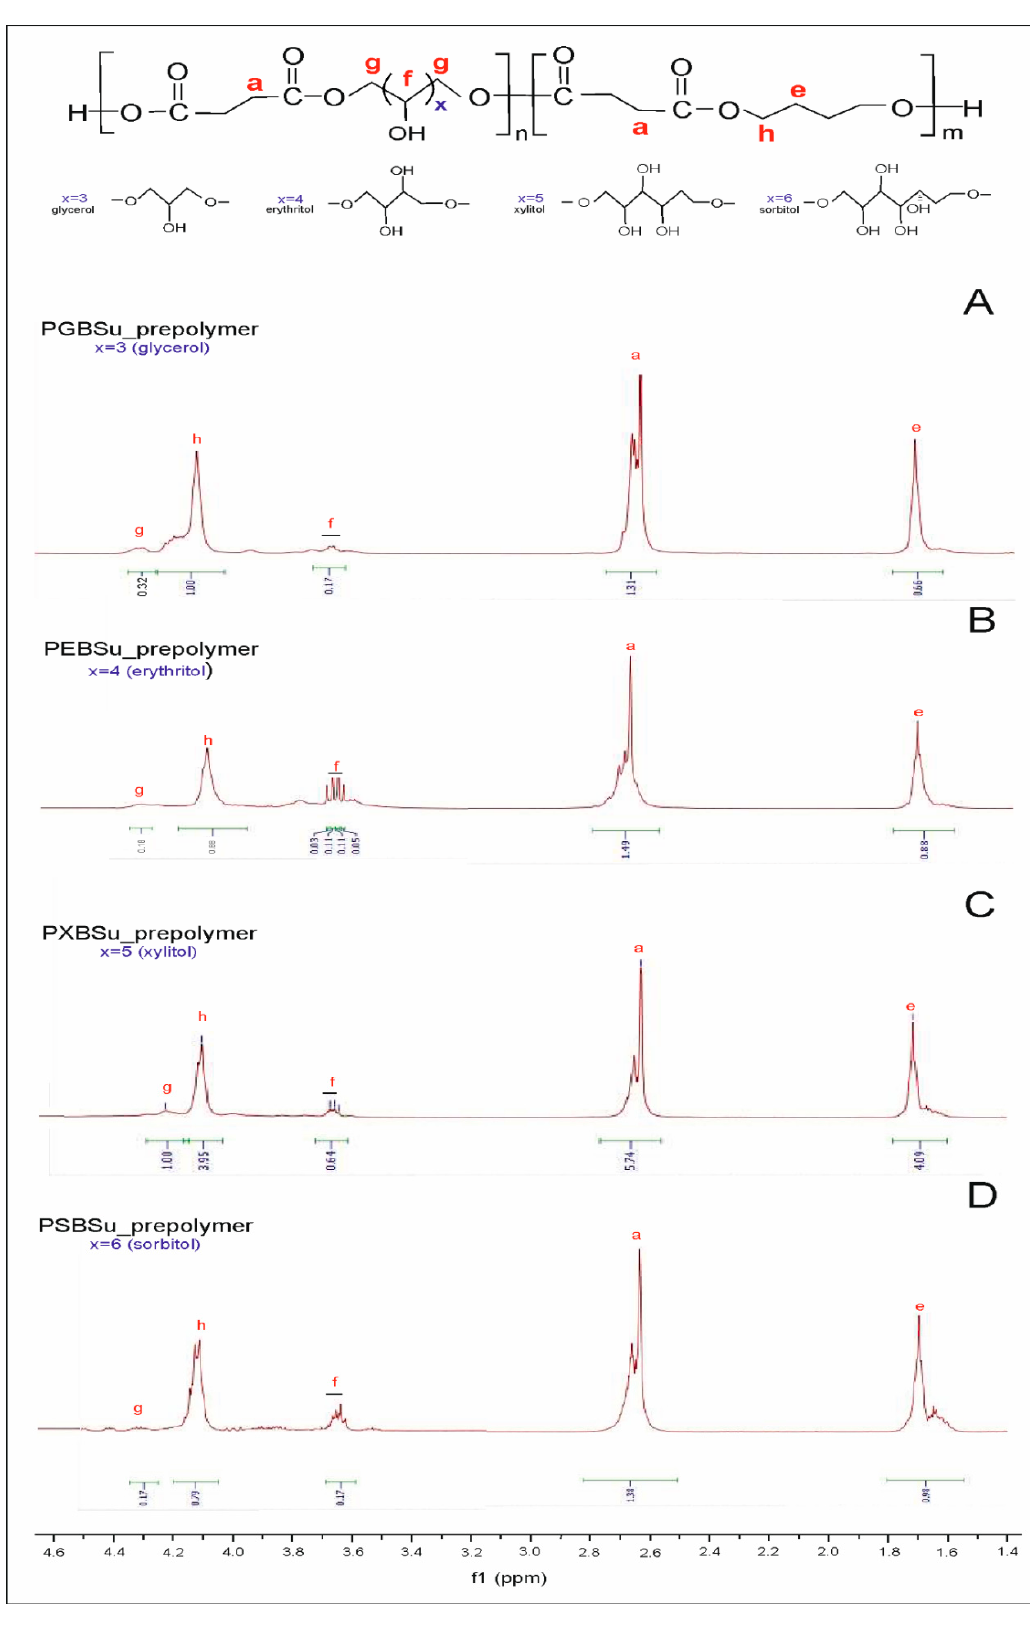
Figure 3. 1 H NMR of PGBSu ( A ), PEBSu ( B ), PXBSu ( C ), and PSBSu( D ) prepolymers.